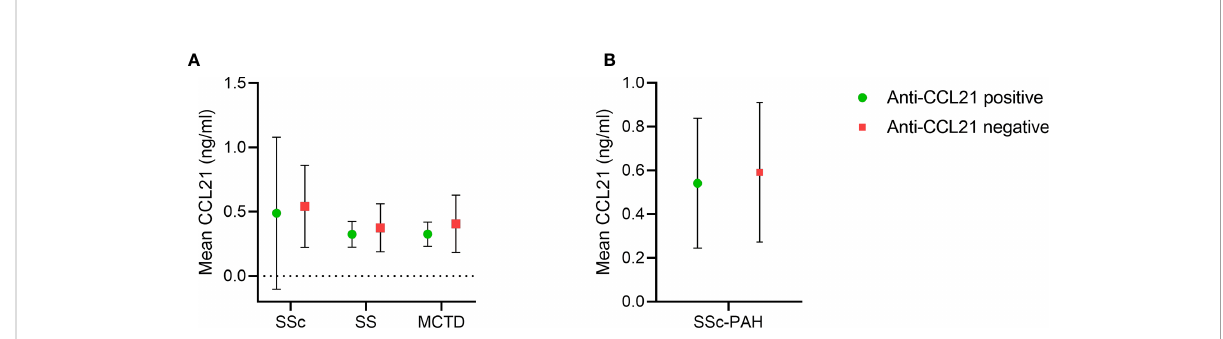
FIGURE 7 CCL21 levels in SSc, SS and MCTD of anti-CCL21 antibody positive and negative patients. (A) Mean serum levels of CCL21 in anti-CCL21 antibody positive (green) and anti-CCL21 antibody negative (red) patients in SSc, SS and MCTD. (B) Mean serum levels of CCL21 of anti-CCL21 antibody positive (green) and anti-CCL21 antibody negative (red) patients in SSc patients diagnosed with PAH.